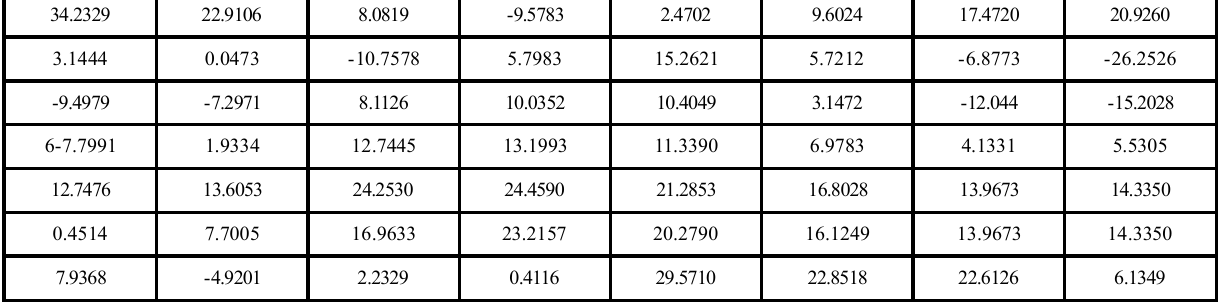
TABLE 1. THE ORIGINAL MATRIX